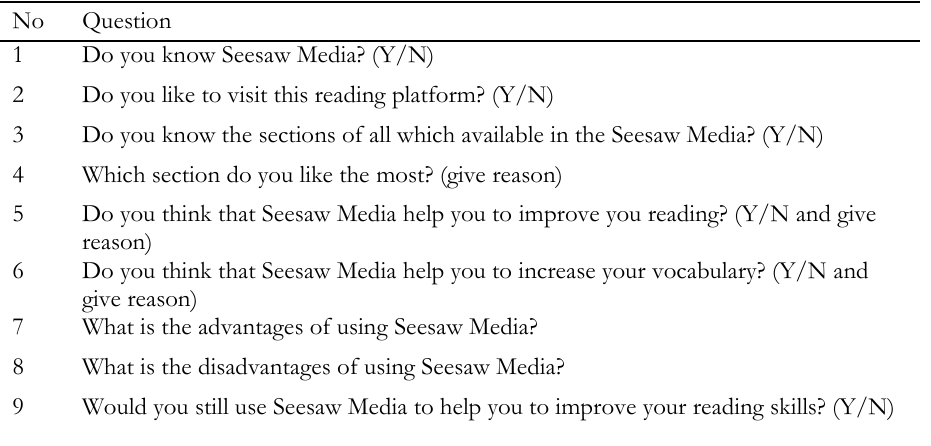
Table 1. Questions of Questionnaire